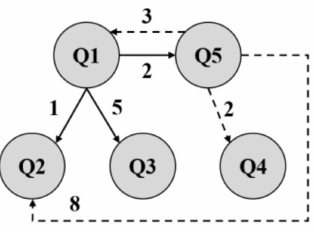
Figure 5. Example of Q&A set frequency graph ( Q 1 , Q 5